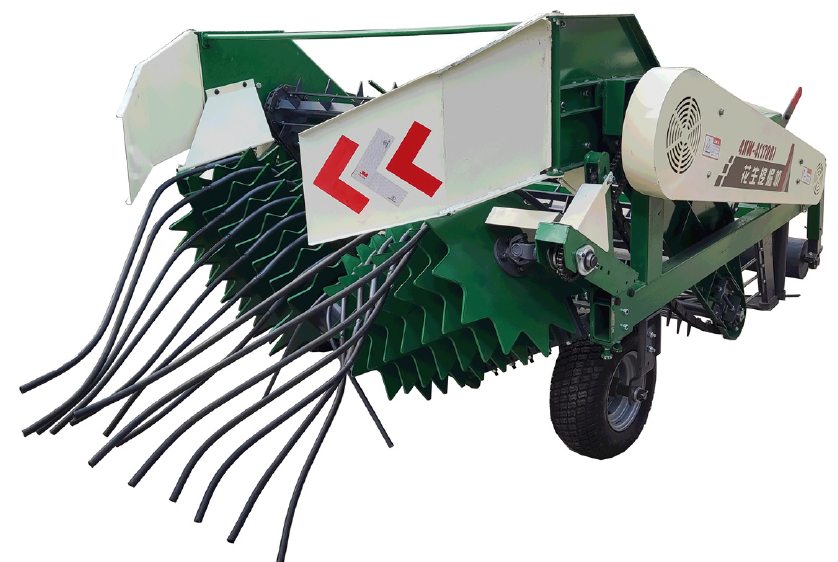
Figure 3. Peanut digger-inverter experimental machine.